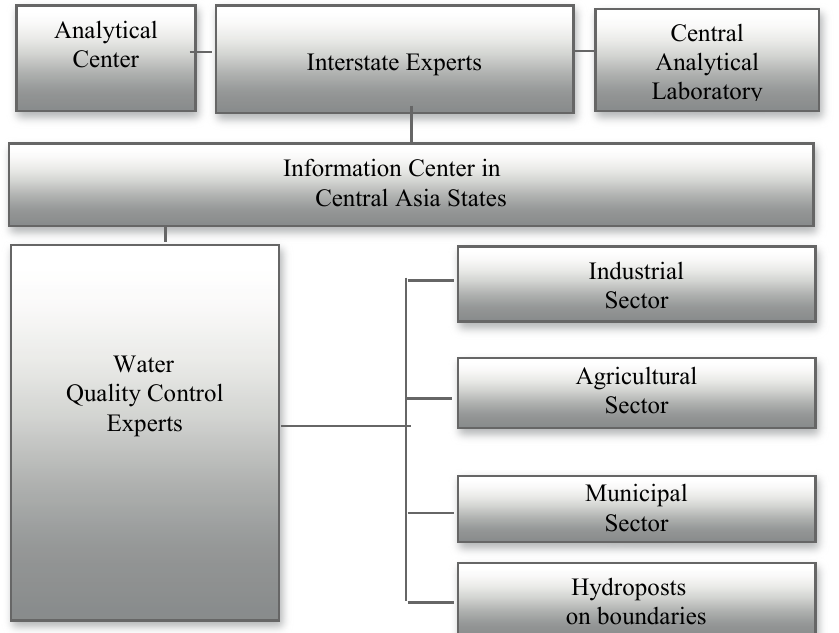
Fig. 4 Structure of the Interstate Coordination Water Quality